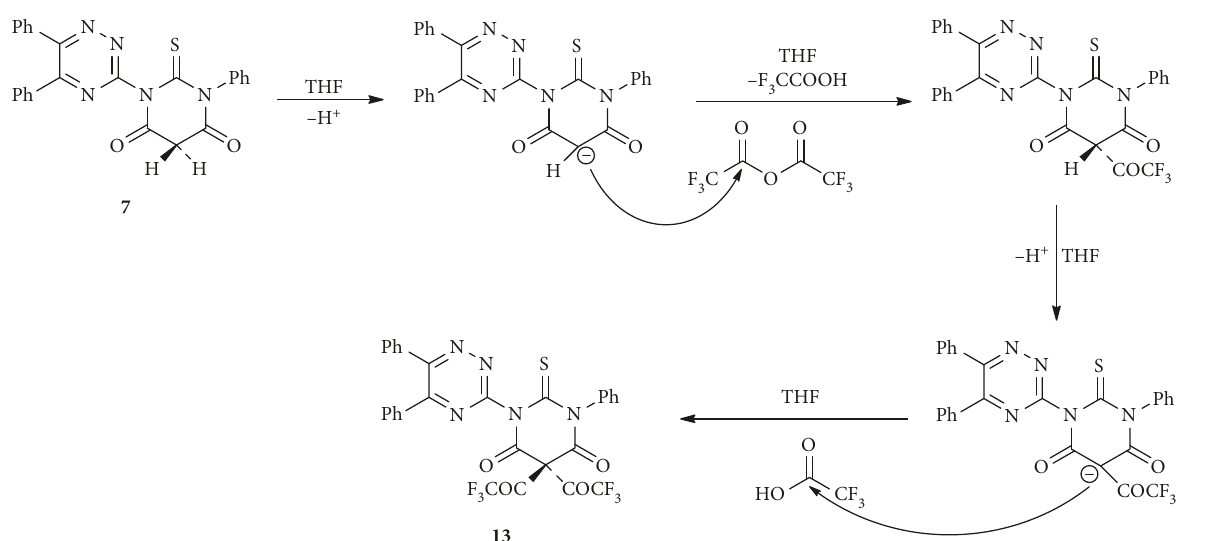
Figure 1: Formation of compound 13 from 7 .